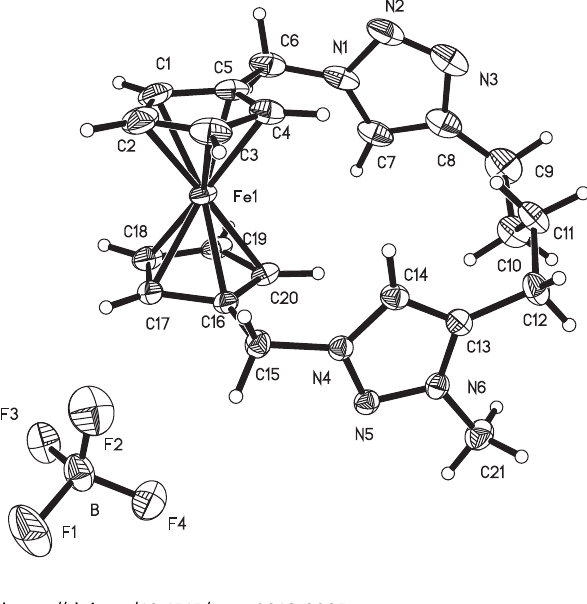
Table 1: Data collection and handling.